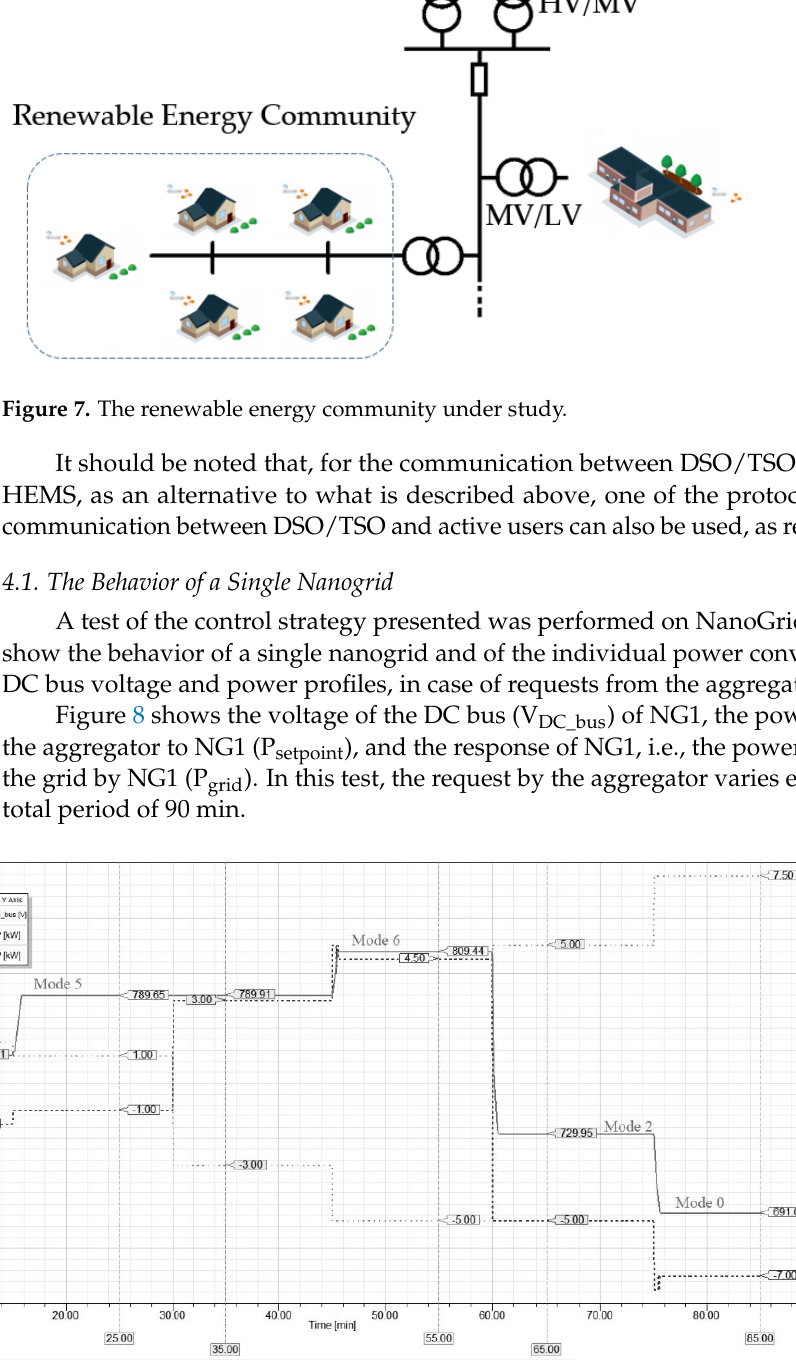
Figure 9. Power profile of NG1: SOC and power absorbed/supplied from the battery storage, power absorbed from the critical load (P critical_load ) and not critical (P load ), power production from PV plant (P PV ). In the first 15 min interval, the setpoint request is to feed into the grid a power of 1.5 kW. The NG1 feeds into the grid a P grid equal to − 1.5 kW (Figure 8) and the operating mode is Mode_4 (V DC_bus = 770 V). In fact, as can be seen from Figure 9, the PV delivers a power of 6 kW, of which 2.5 kW are used to charge the battery storage (the SOC increases), 2 kW are used to power the loads, critical and not, therefore, 1.5 kW are fed into the grid, which coincides with the aggregator’s request. In the second interval, the aggregator asks to reduce the input into the grid by 0.5 kW, then the power exchanged with the grid is reduced to − 1 kW (Figure 8) and the DC bus voltage increases, passing from Mode_4 to Mode_5 (V DC_bus = 790 V). As can be seen